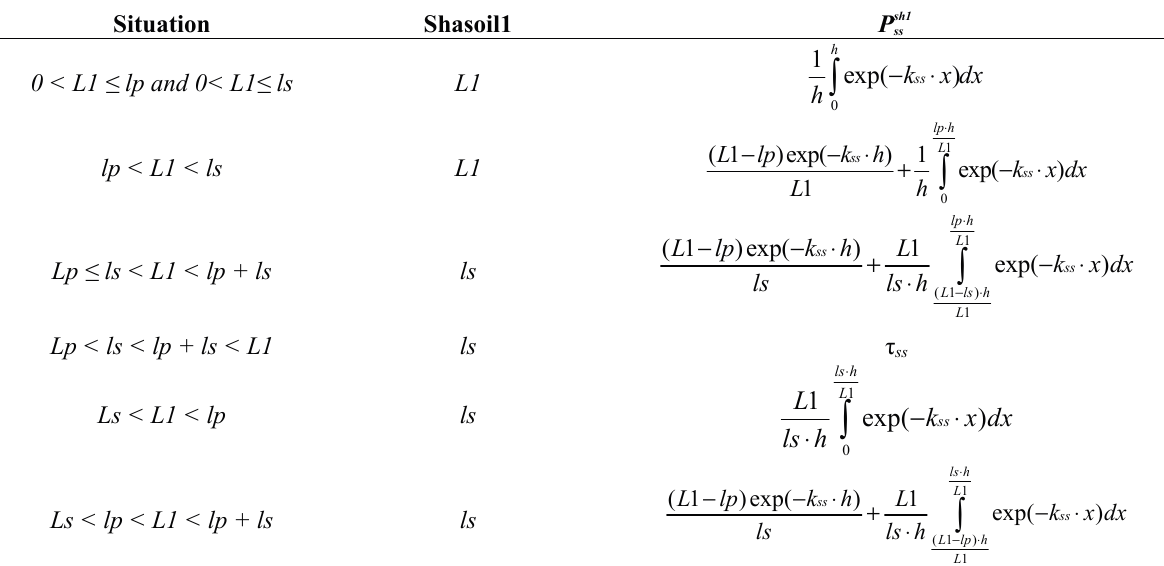
Table 1. The relative horizontal projected length and average gap probability of the direct light in the solar direction for the shadowed background for the first category (sh1) in different nadir viewing direction